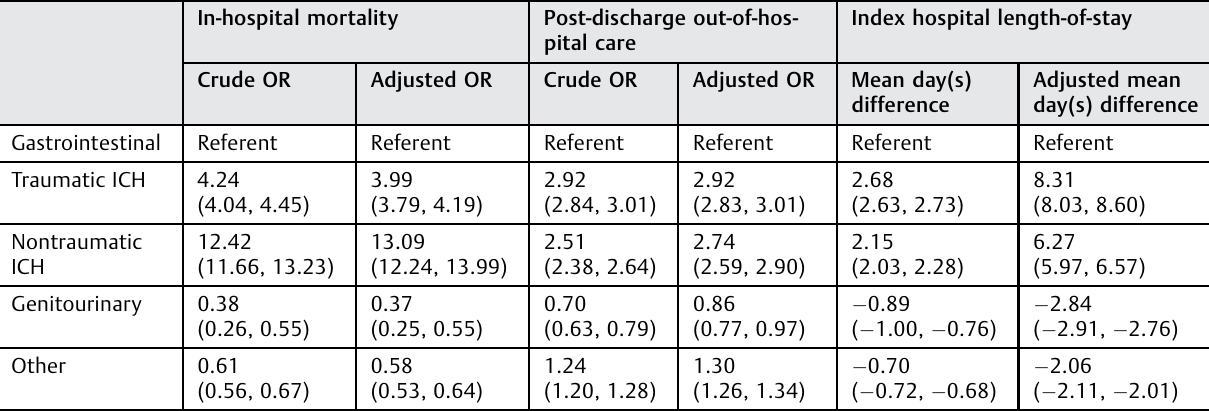
Table 3 Crude and adjusted odds ratios for outcomes strati fi ed on bleed type In-hospital